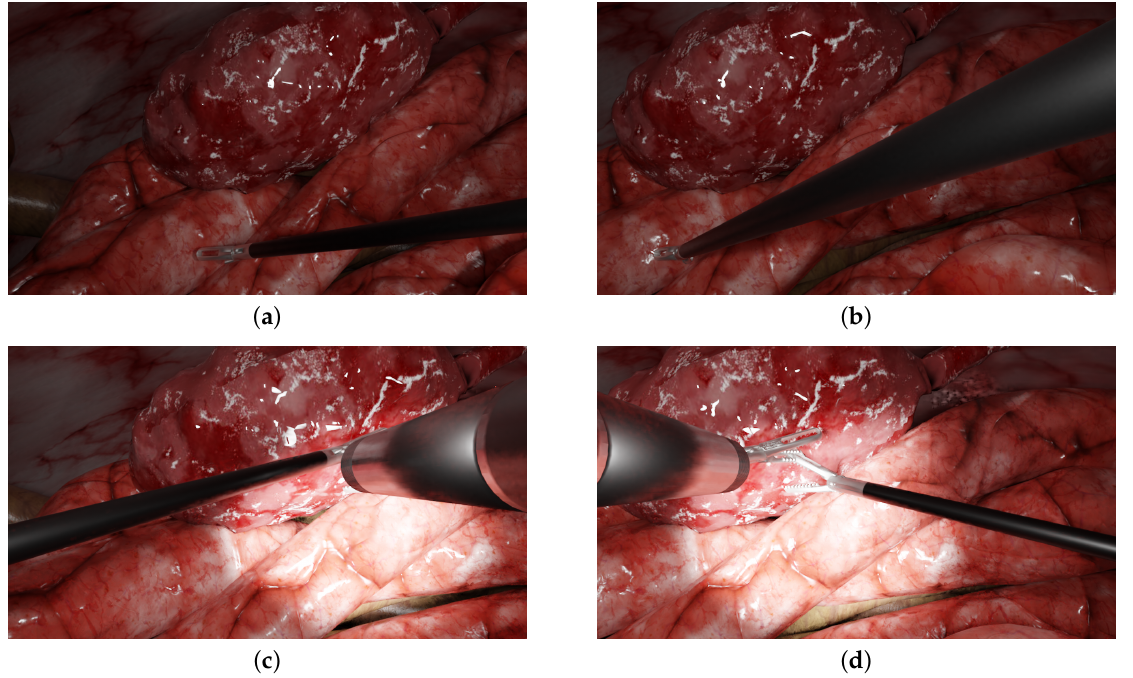
Figure 2. Examples of typical laparoscopic situations: images from a multi-camera system rendered in the simulated environment. The left and right columns display the left and right simulated images of the prototype, respectively. ( a , b ) One forceps with no endoscope ( c , d ), two forceps, one endoscope and a